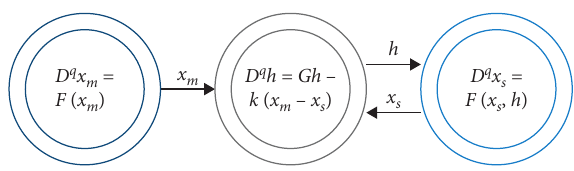
Figure 2: Schematic representation of unidirectionally coupled fractional-order systems interacting via fractional-order dynamic